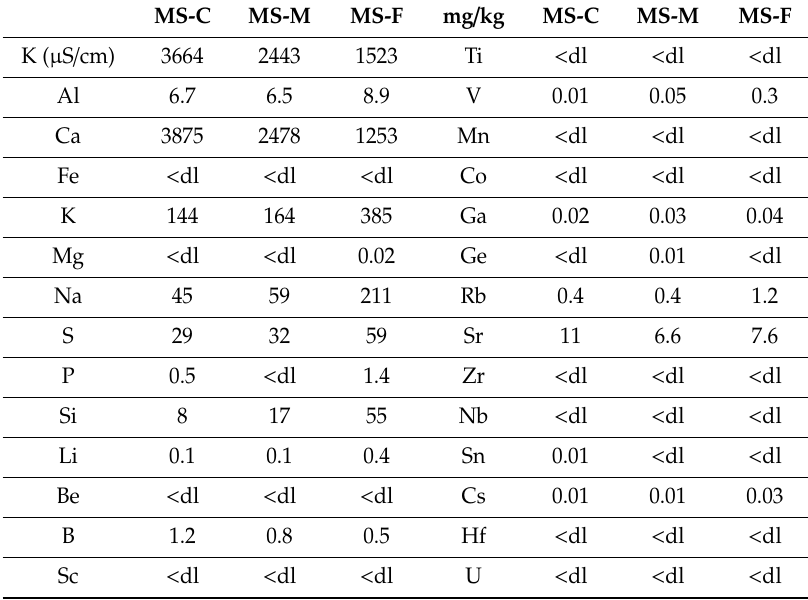
Table 2. The conductivity ( µ S / cm) and concentrations (mg / kg)of major and trace element sin the EN-12457 leachates from three acoustic products.